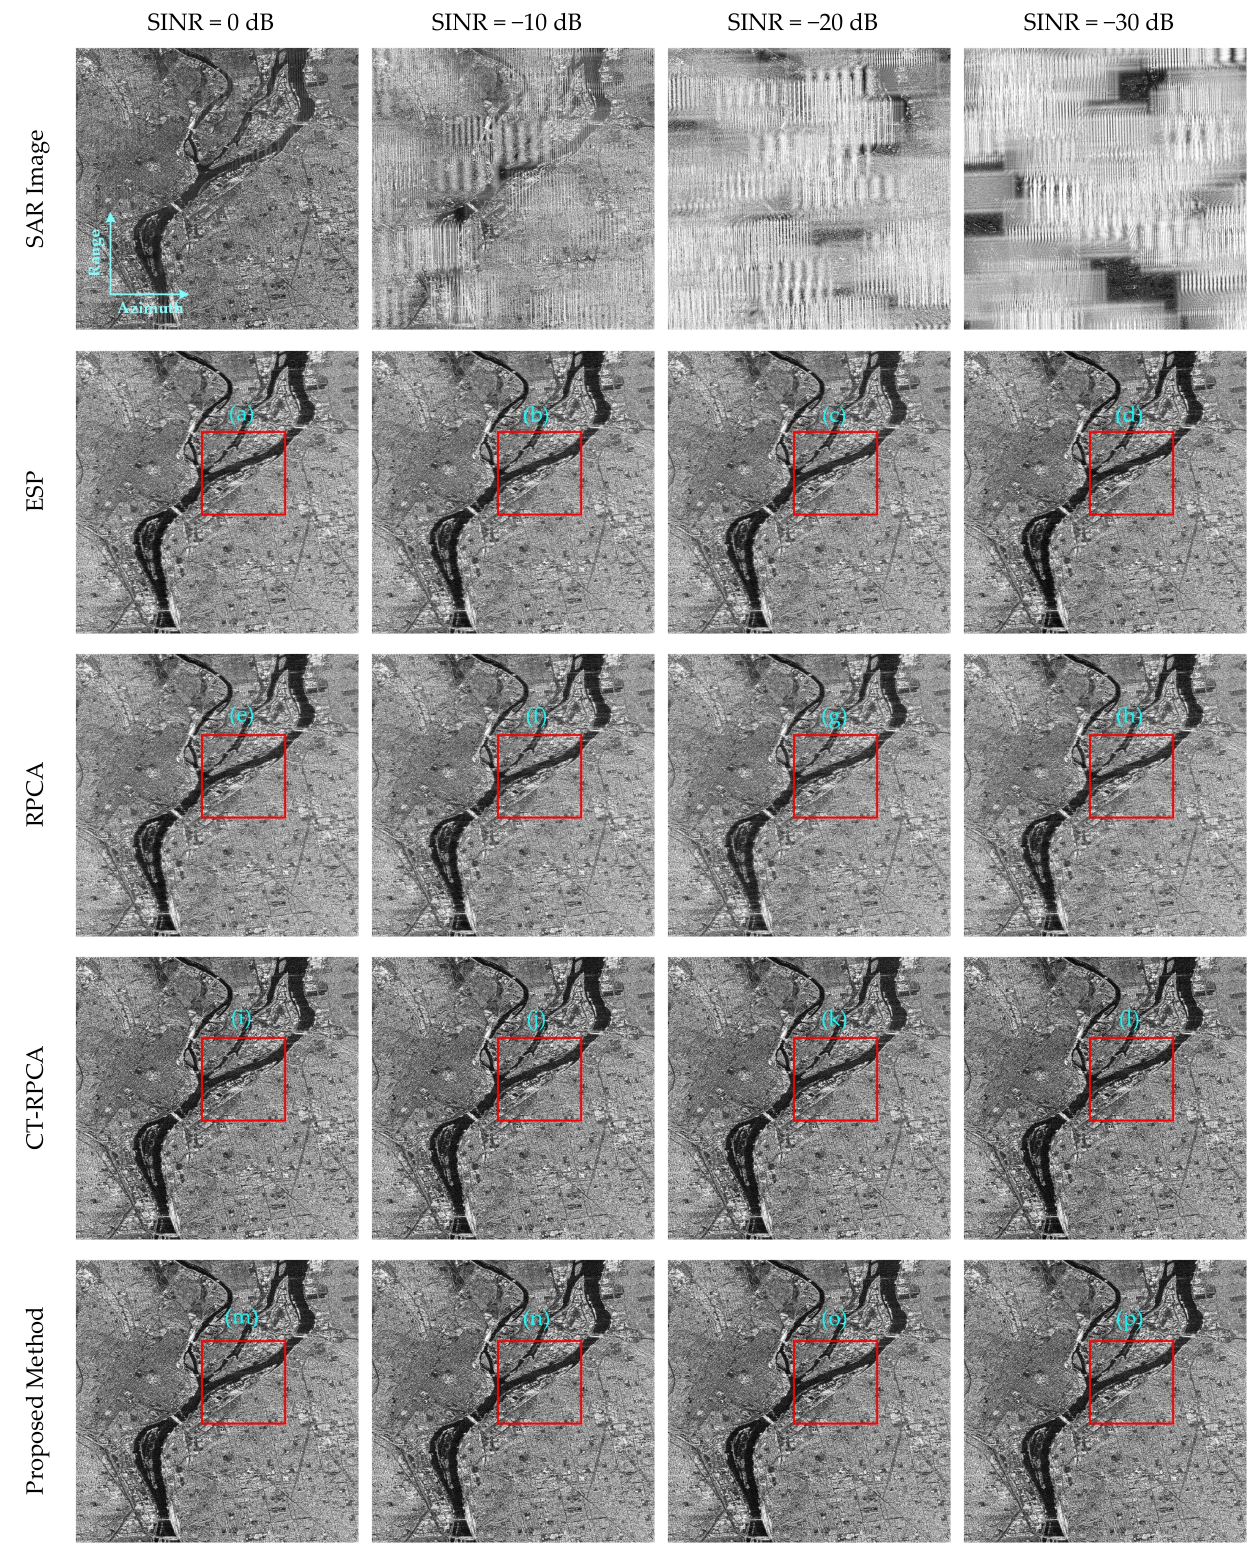
Figure 6. RFI mitigation performance for the ESP, RPCA, CT-RPCA, and proposed approach under different SINRs. ( a – p ) ROIs for RFI mitigation results of different methods.